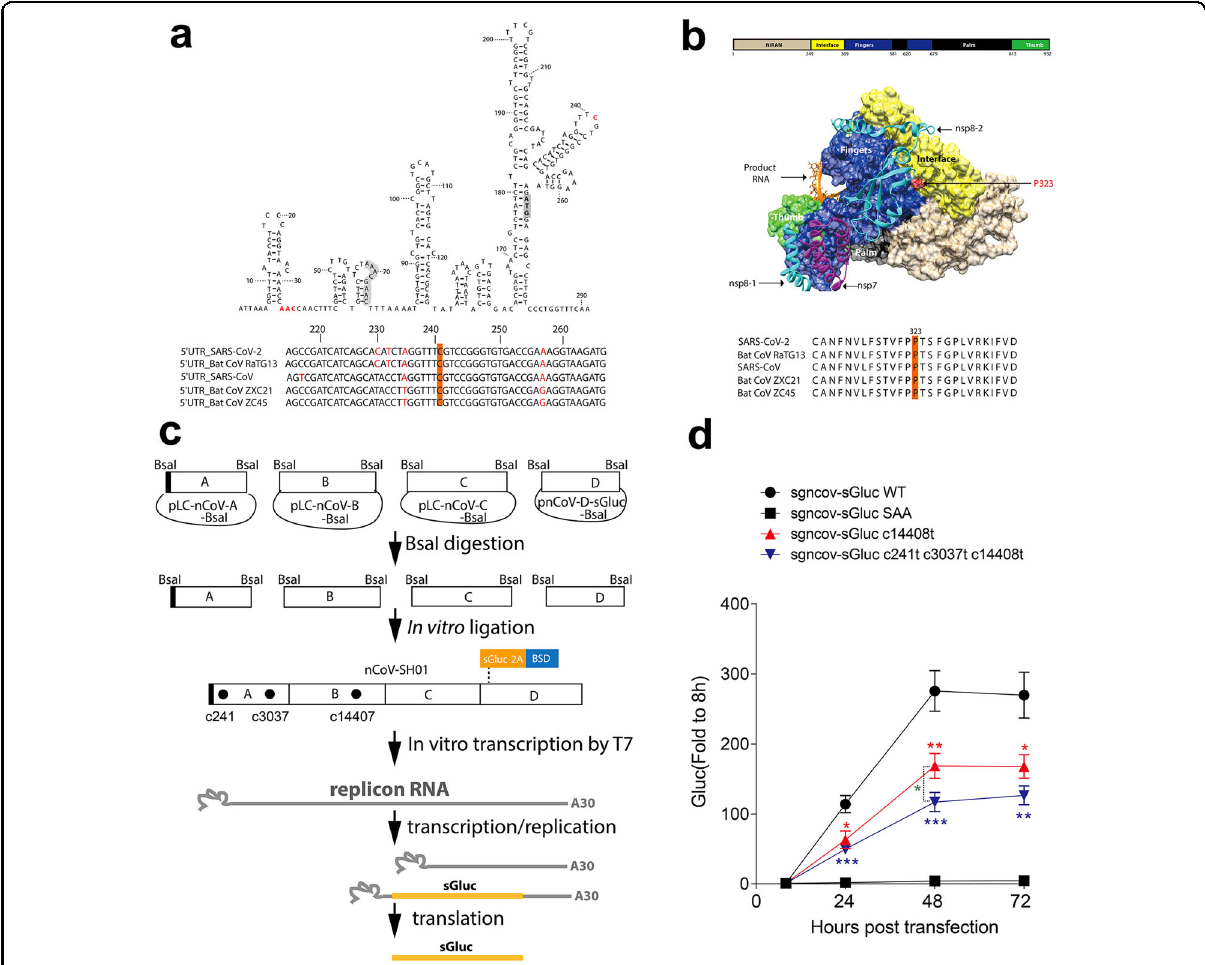
Fig. 4 Dominant co-mutation attenuates viral replication. a Predicted RNA structure of the SARS-CoV-2 5 ′ UTR. RNA structure of the 400-nt 5 ′ UTR was predicted by “ RNAstructure ” (http://rna.urmc.rochester.edu/RNAstructureWeb). The start codon for nsp1 is gray, the TRS-L is orange, and the mutated nucleotides are red. The bottom panel shows the alignment of the 5 ′ UTR of SARS-CoV-2 with 5 ′ UTRs of related viruses, with c241 highlighted. b Structure of SARS-CoV-2 RNA-dependent RNA polymerase (RdRp) or RNA complex. The structure of SARS-CoV-2 RdRp/RNA complex (PDB, 6X2G) was visualized by Chimera (UCSF). The P323 mutation is highlighted in red, with the alignment of the amino acid sequences of SARS- CoV-2 and related viruses near the P323 position. c Schematic of the in vitro ligation system for SARS-CoV-2 replicon. Four plasmids encompassing the viral genome were digested by BsaI to release the four fragments. After gel puri fi cation, the fragments were ligated by T4 ligase. The ligation products were puri fi ed and used as template for RNA in vitro transcription. sGluc, secreted Gaussia luciferase; 2A, foot-and-mouth disease virus (FMDV) 2A peptide; BSD, blasticidin. d Huh7 cells were co-transfected with in vitro transcribed replicon RNA (wild type (WT) or the indicated mutants) and an mRNA encoding the SARS-CoV-2 N protein. The luciferase activity in the supernatants was measured at the time points indicated. Medium was changed at 8 h post-transfection. Data are shown as mean ± SEM ( n = 8). SAA, the NSP12 polymerase active-site mutant. Unpaired Student ’ s t - test was performed between the mutants and WT and between the mutants as indicated. * P < 0.05, ** P < 0.01, *** P <